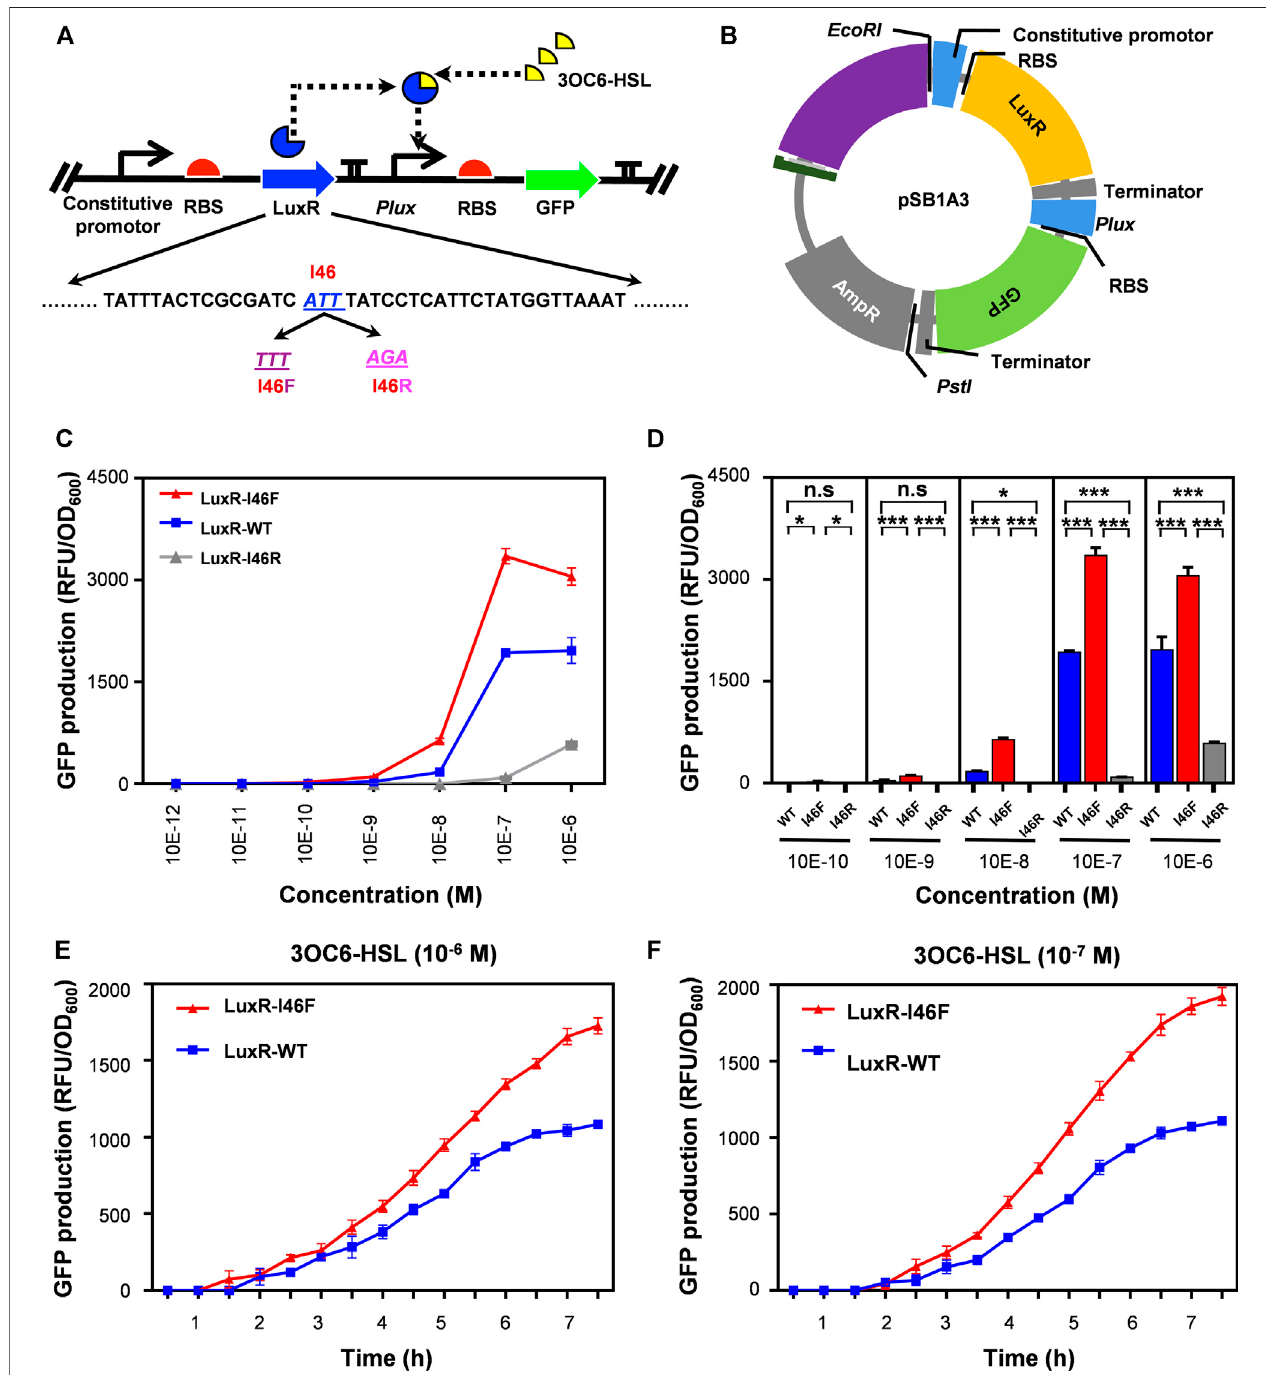
FIGURE 4 | Gene circuits applying V. fi scheri LuxR with modulated sensitivity to 3OC6-HSL. (A) Design of synthetic gene circuit using components from the Registry of Standard Biological parts, LuxR as the sensor, and GFP as the reporter. (B) Plasmid construction. (C,D) Plasmids encoding gene circuits including WT or mutant forms of LuxR were transformed into Escherichia coli DH5 α , and fl uorescence was measured to determine the response of LuxR to 3OC6-HSL. The data were fl uorescence fi rst corrected by subtracting the negative control fl uorescence, and then normalized by bacterial density (OD 600 ). (E,F) Curves of relative intensity change with temperature at (cid:4) 1 × 10 – 6 M (E) and (cid:4) 1 × 10 – 7 M (F) 3OC6-HSL. All the results are the means of triplicate experiments.